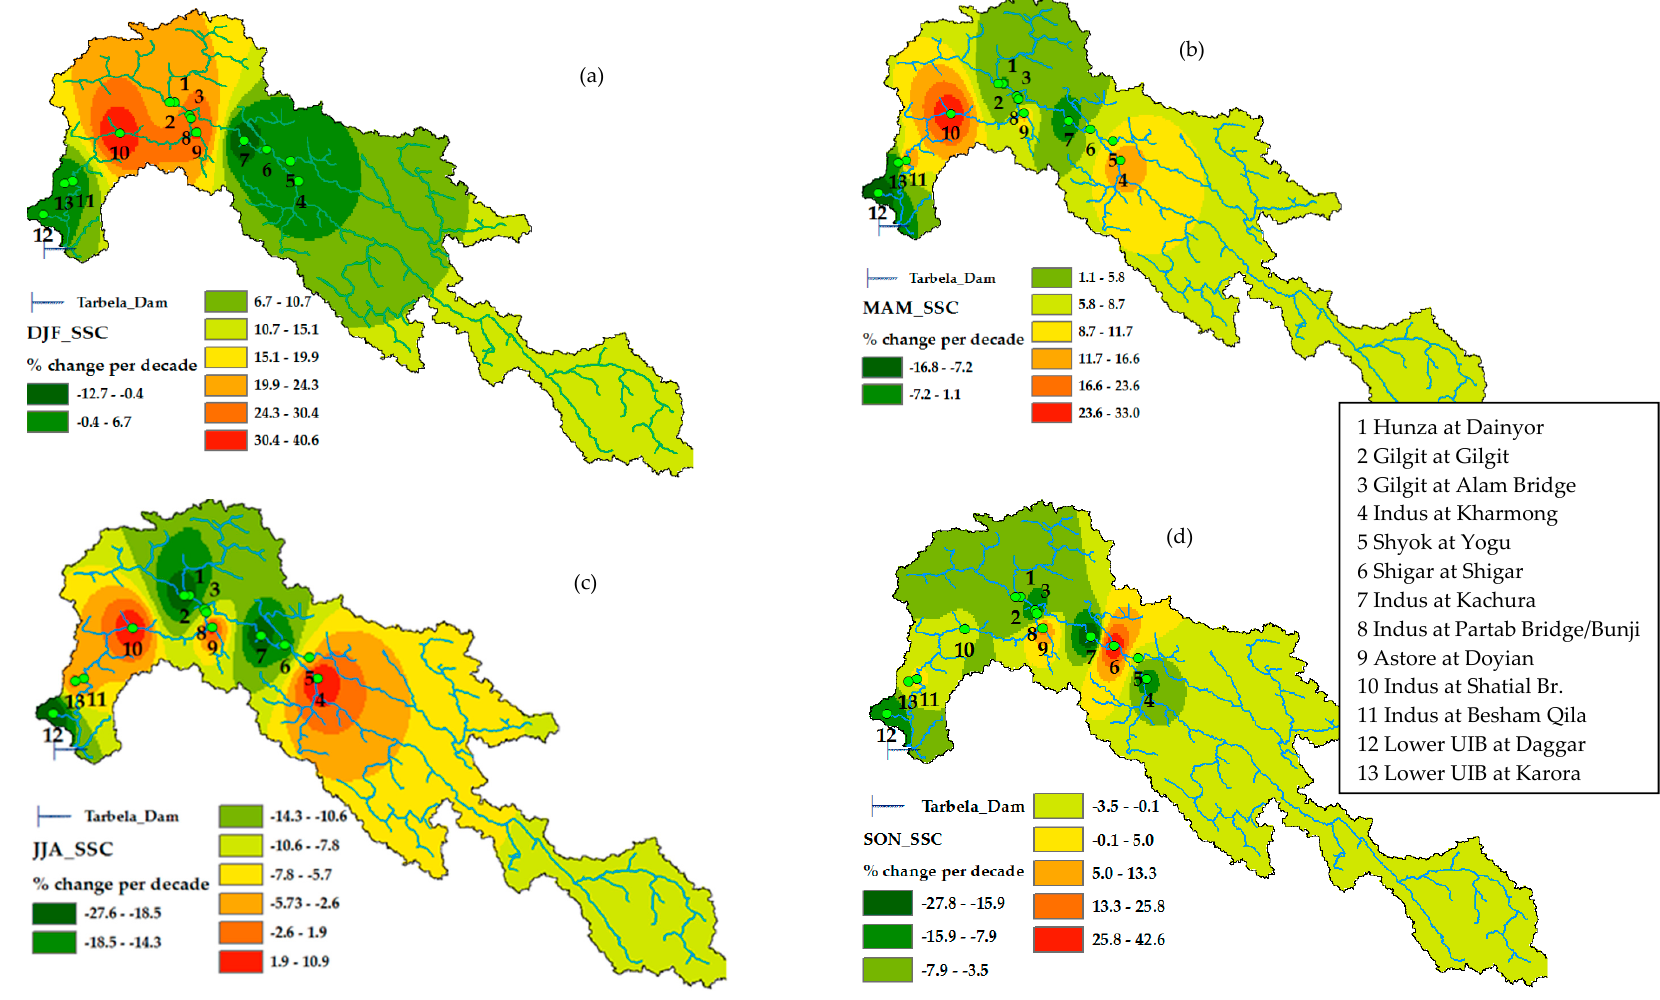
Figure 3. Seasonal suspended sediment concentration (SSC) trends spatially distributed over the basin with % of changes per decade in % of mean values for the whole period. ( a ) DJF (winter), ( b ) MAM (spring), ( c ) JJA (summer), ( d ) SON (autumn) seasons.